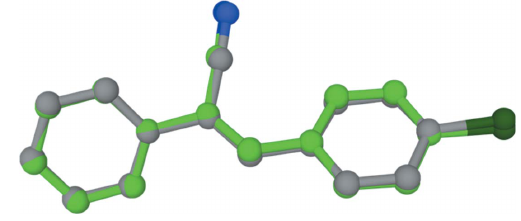
Figure 2 Structural overlay of the X-ray (grey) and optimized (green) structures.